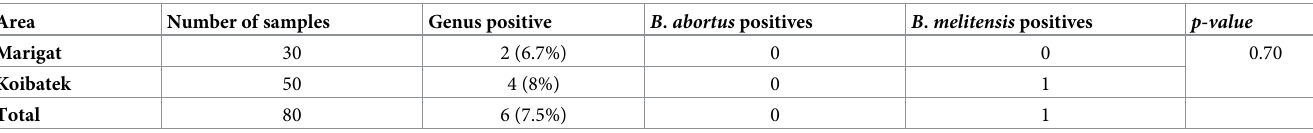
Table 4. Results of molecular analysis using real-time PCR. Area Number of